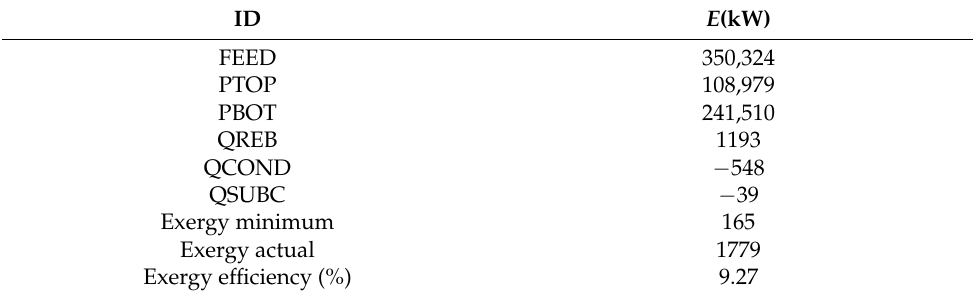
Table 3. Exergy analysis of the CDC system.